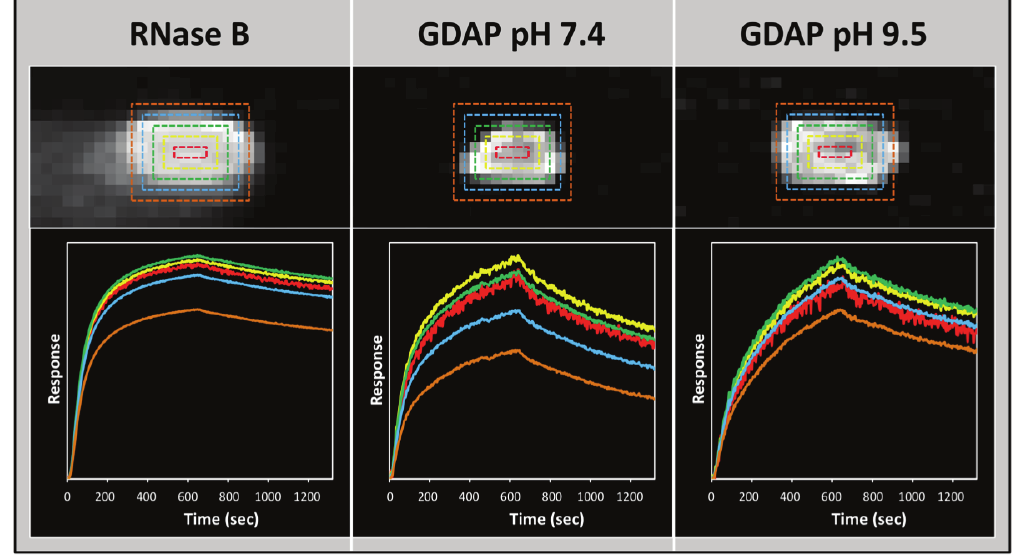
were consistent across all three spots, reinforcing the importance of ROI selection in achieving comparable and optimized responses. Figure 6. Influence of user ROI selection on SPRi results for Con A binding to printed RNase B (glycoprotein), GDAP pH 7.4, and GDAP pH 9.5 spots. (Top) SPRi image showing five concentric ROIs selected around the center of each printed glycan array element—printed spots range from 150-250 microns in diameter. (Bottom) Sensorgrams associated with each concentric ROI (red, yellow, green, blue and orange) show non- uniform response across the printed array element, and significant decreases in signal associated with large ROIs that extend beyond the spot boundary.